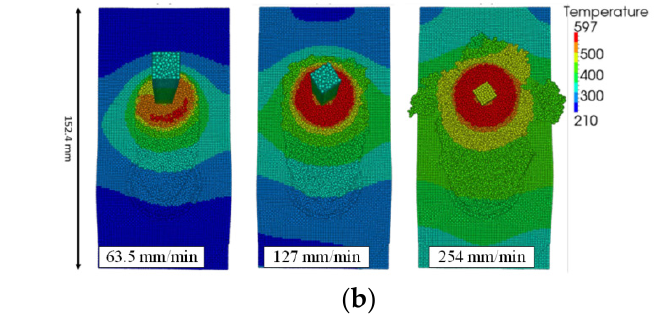
Figure 15. Temperature distribution pattern of AFSD model [60]. ( a ) Temperature distribution. ( b ) Temperature asymmetry at three feed rates.